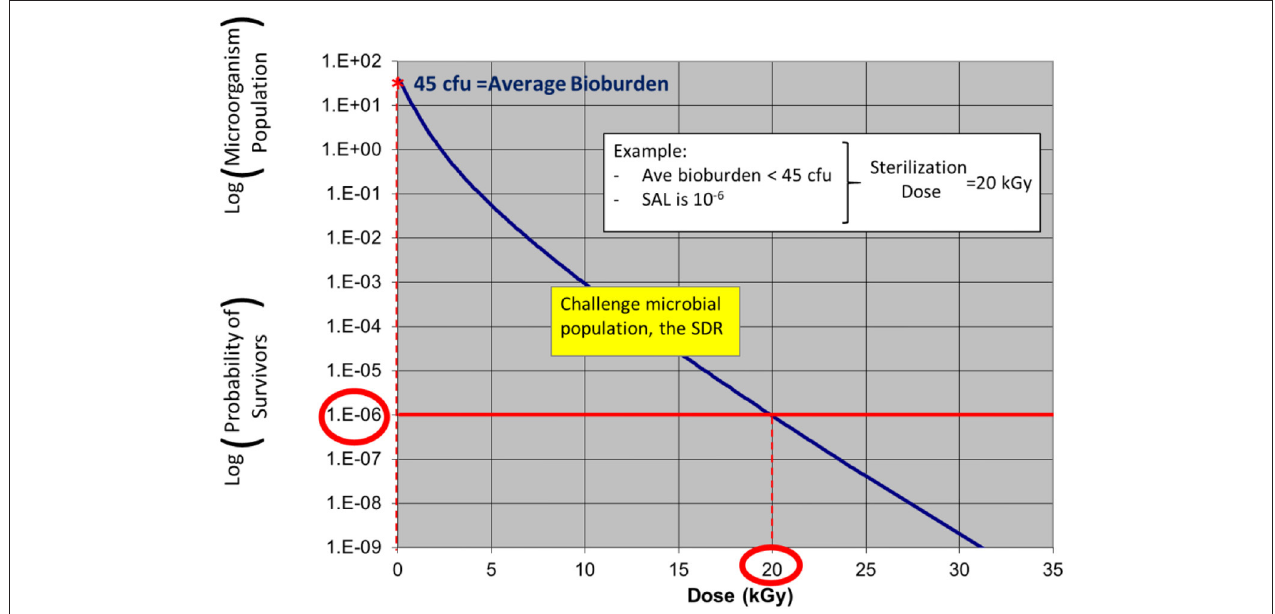
FIGURE 3 | ISO 11137 process definition—establishing a radiation sterilization dose of 20 kGy corresponding to product bioburden < 45 cfu. (note: due to the nature of the SDR, the traditional straight log-linear curve is not applied as log-linear is only applicable for a single microorganism challenge).